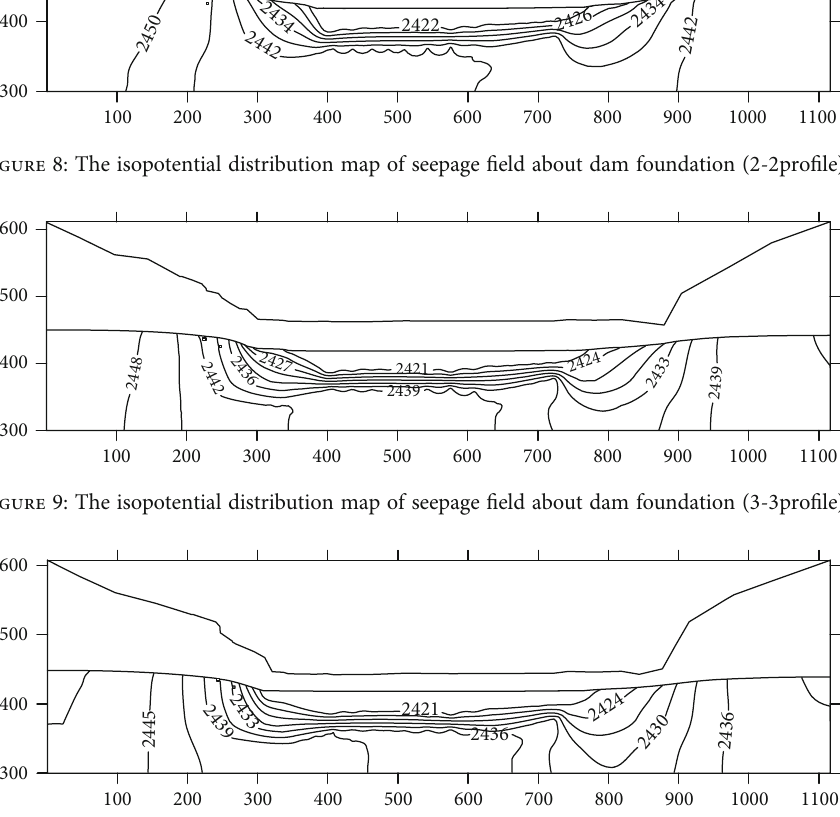
Figure 10: The isopotential distribution map of seepage fi eld about dam foundation (4-4 pro fi